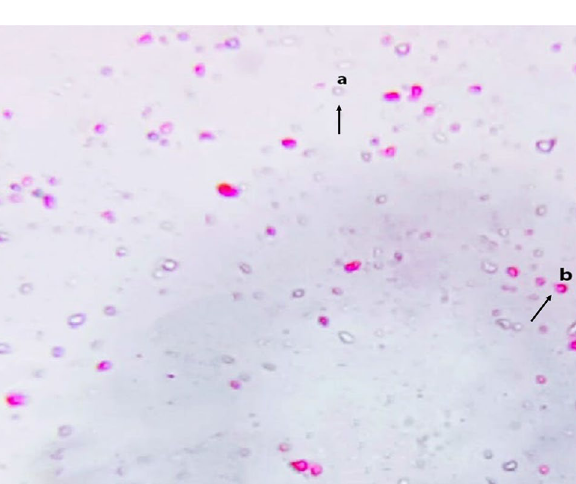
Figure 2. C. parvum oocysts treated with AgNPs and stained with 0.1% eosin dye ( a ) viable oocysts (unstained) and ( b ) inviable oocysts (stained red) at X